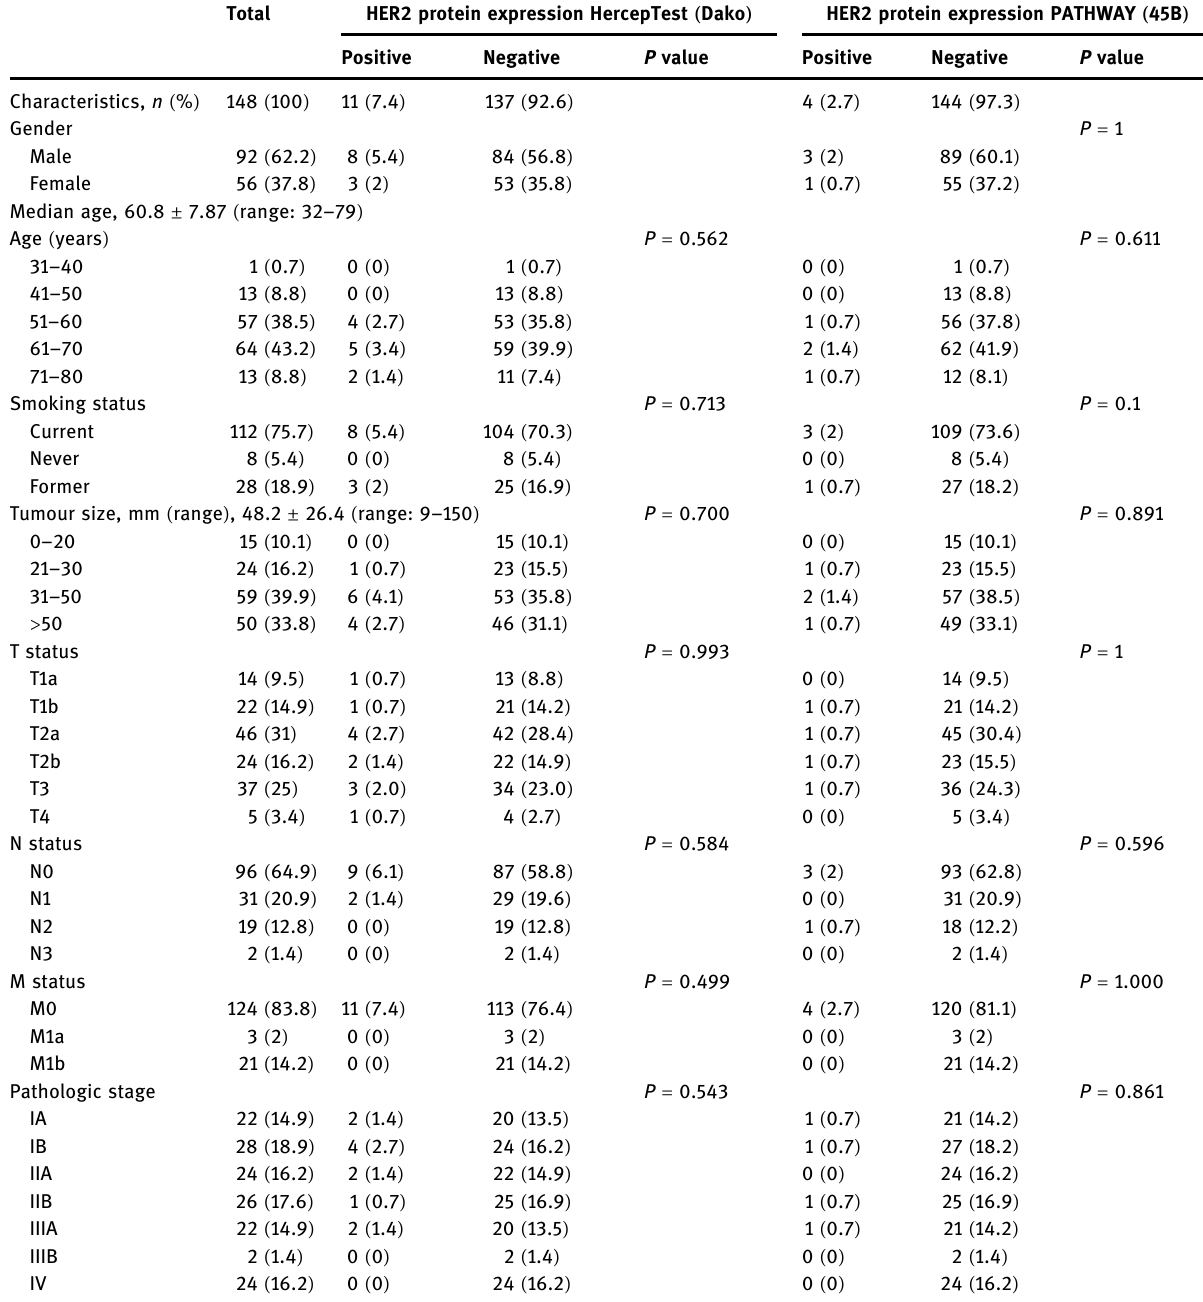
Table 1: Patients ’ characteristics according to HER2 protein overexpression Total HER2 protein expression HercepTest ( Dako ) HER2 protein expression PATHWAY ( 45B